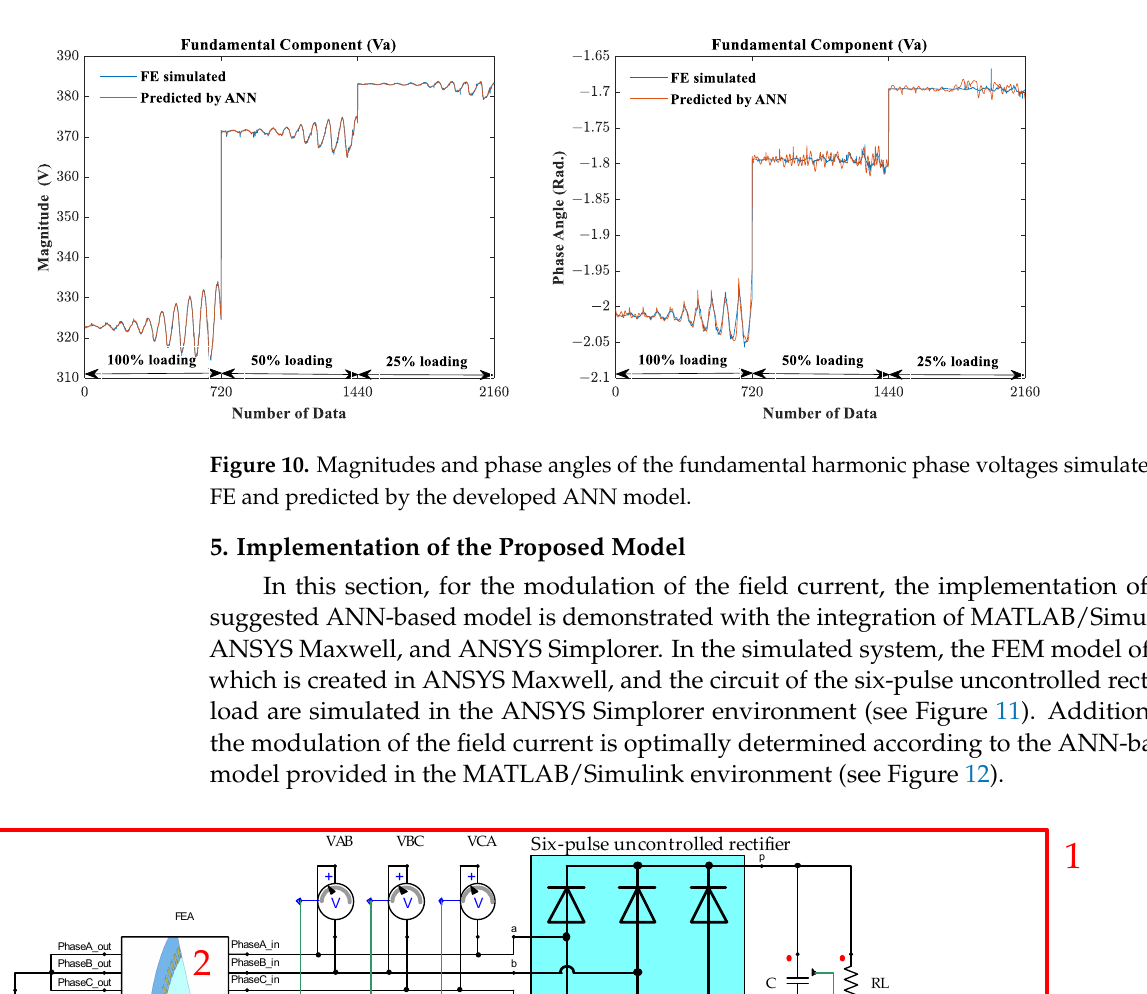
Table 2. MSE values of the ANN.